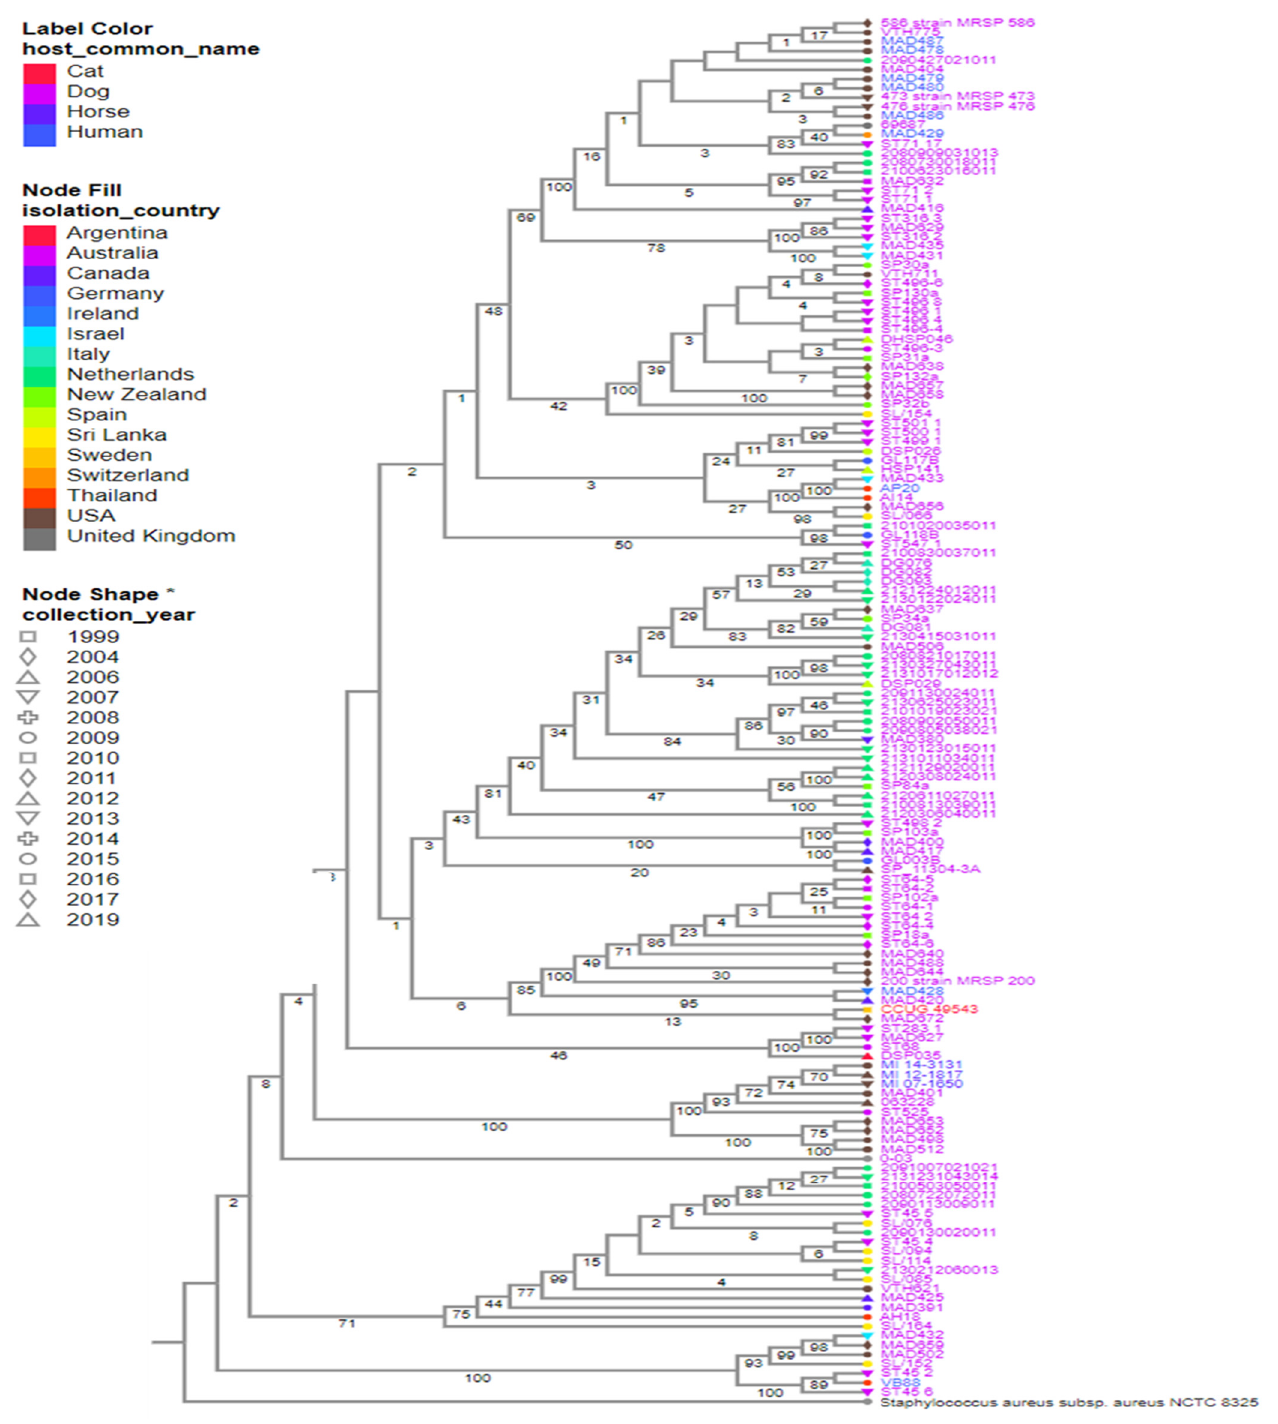
Figure 2. Strains of 147 S. pseudintermedius isolated from humans and animals worldwide. Reference genomes, S. pseudintermedius SP_11304_3A and S. aureus NCTC 8325, were also included. The color of the strain’s name represents the hosts, the color of the nodes indicates the country of isolation, and the node shape indicates the year of isolation. Estimated confidence is shown on each internal branch of the tree. * is just a form of emphasis on Node shape based on years. It was not used to represent the collection year type.